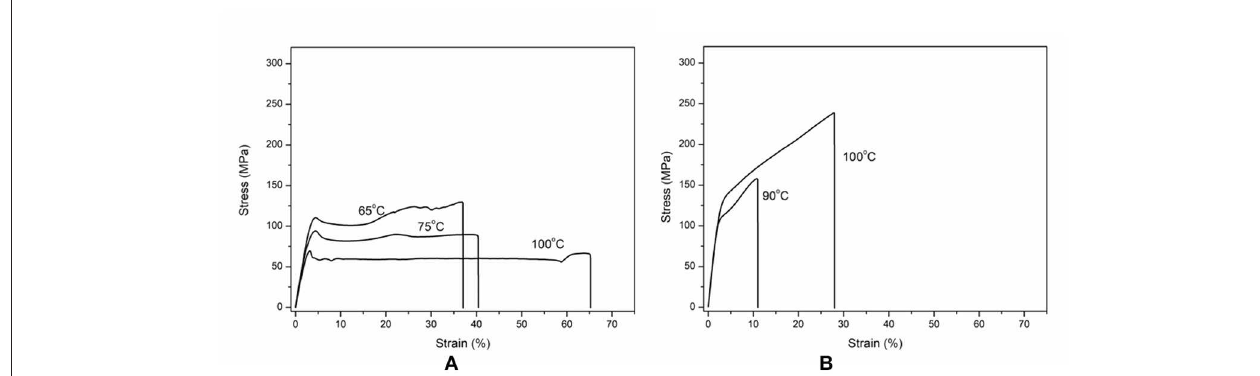
FIGURE 6 | Tensile parameters values as a function of the drawing temperature for the PLA filaments drawn at two different draw ratios. (A) Young’s modulus. (B) Tensile strength. (C) Strain at break.